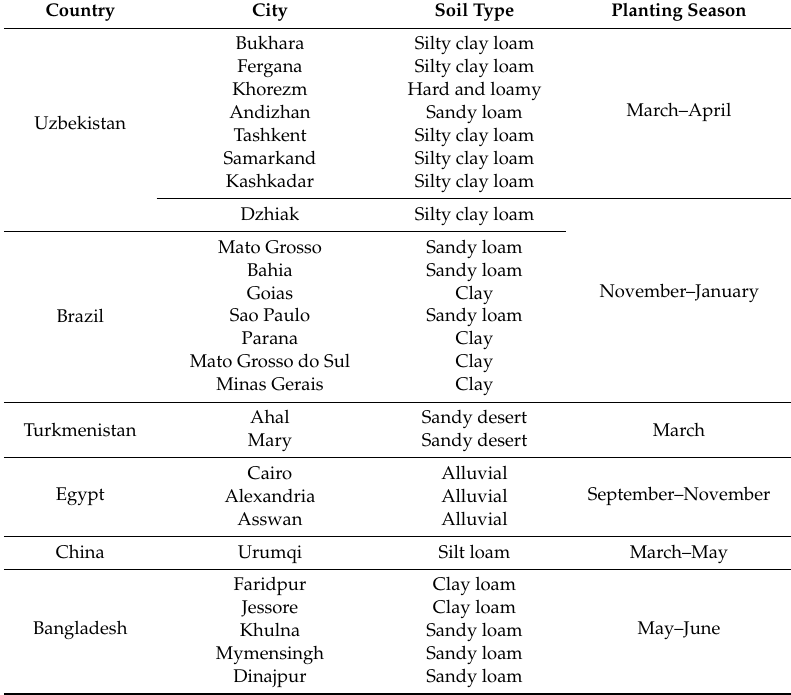
Table A12. Soil type and cotton planting season of di ff erent cotton producing states of Uzbekistan, Brazil, Turkmenistan, Egypt, China and Bangladesh